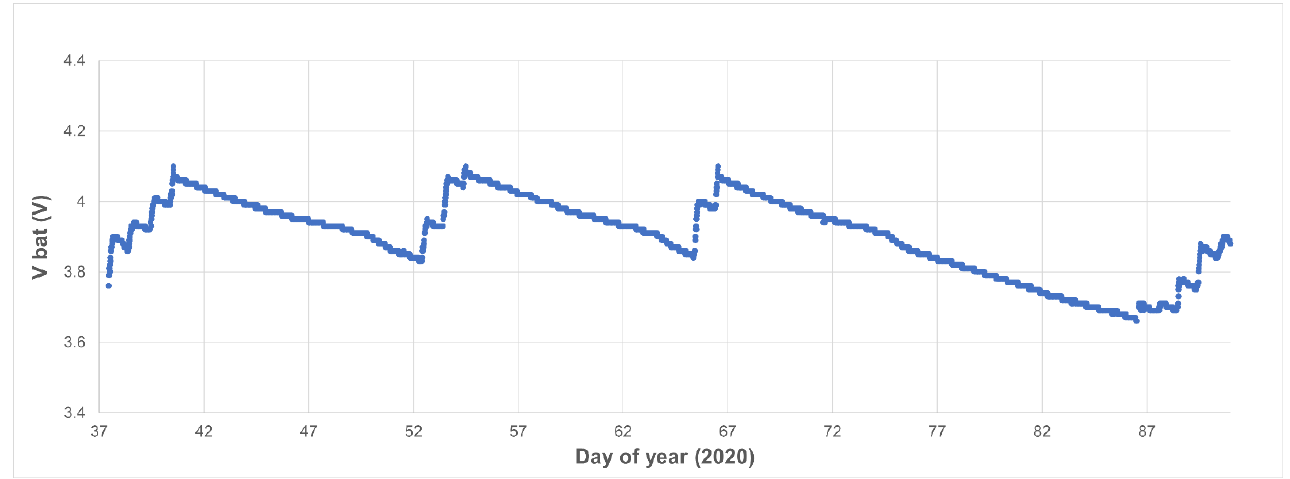
Figure 16. Evolution of the battery voltage of node 23.